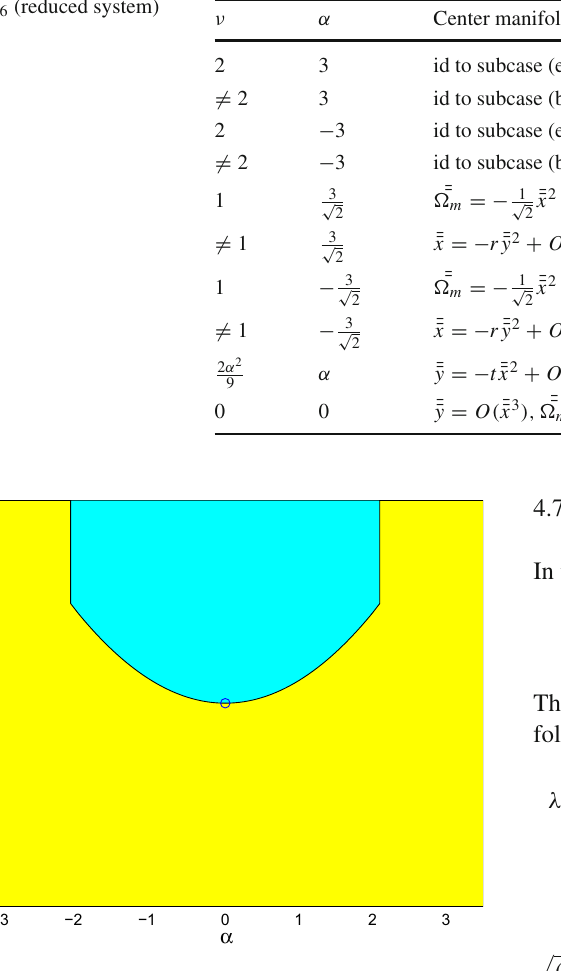
Fig. 1 Stability diagram ( C 5 , C 6 )